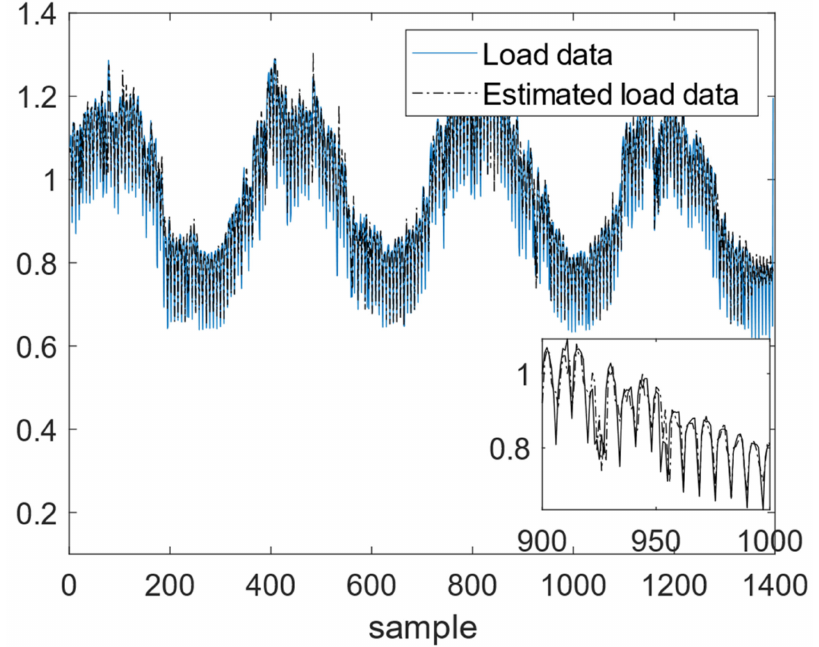
Figure 5. Performance of the proposed prediction method for the Poland electrical load dataset (train set).